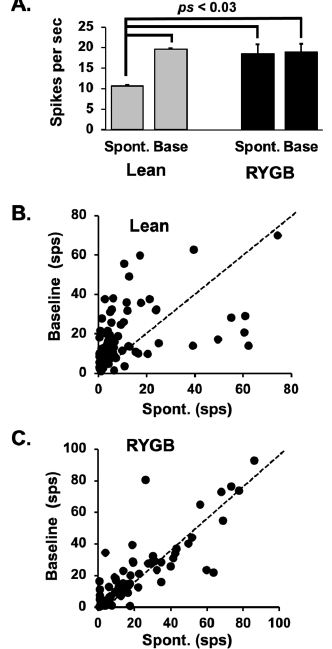
Figure 6. ( A ) Mean ±SEM firing rates during spontaneous (no licking) and baseline (the 1 s just prior to a taste trial) across cells in Lean and RYGB rats. Baseline firing rates in Lean rats and both spontaneous and baseline firing rates in RYGB rats were significantly greater that spontaneous firing rates in Lean rats. See text for details. ( B , C ) Scatterplots of individual average spontaneous ( x -axis) vs. average baseline ( y ‐ axis) firing rates in Lean and RYGB rats. Dotted line indicates when spontaneous and baseline firing rates are equal. In Lean rats, baseline firing rates exceeded spontaneous firing rates in most cases, whereas baseline and spontaneous firing rates were roughly equivalent in the NTS of RYGB rats.